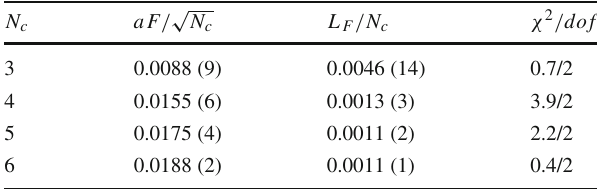
Table 4 NLO Fits for F π for separate values of N c